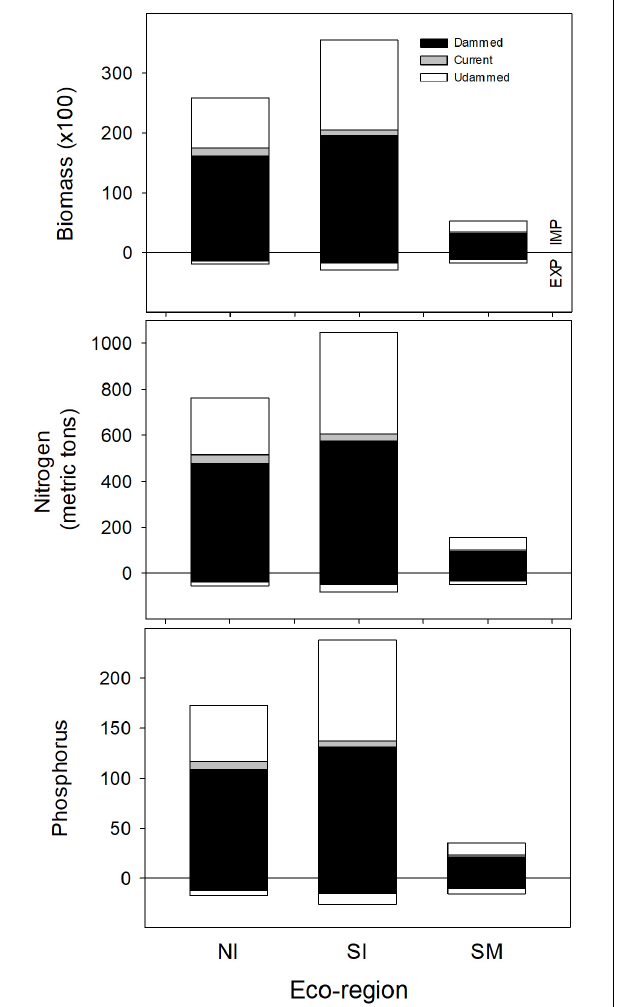
FIGURE 9 | Estimates of annual import (IMP: positive from the zero line) and export (EXP: negative from the zero line) of biomass, nitrogen and phosphorus delivered to each eco-region by American shad through their native range from Canada to Florida under the no passage (“Dammed”), status quo (“Current”), and no dam (“Undammed”) passage